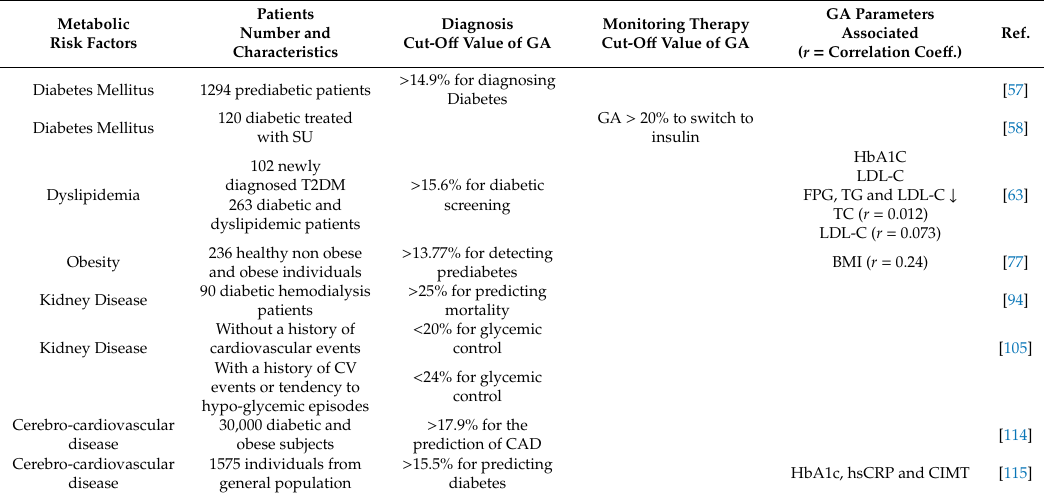
Table 1. Human clinical studies on GA cut-o ff values in the diagnosis and monitoring of therapies of the main cardiometabolic risk factors. Patients Metabolic Number Risk Factors